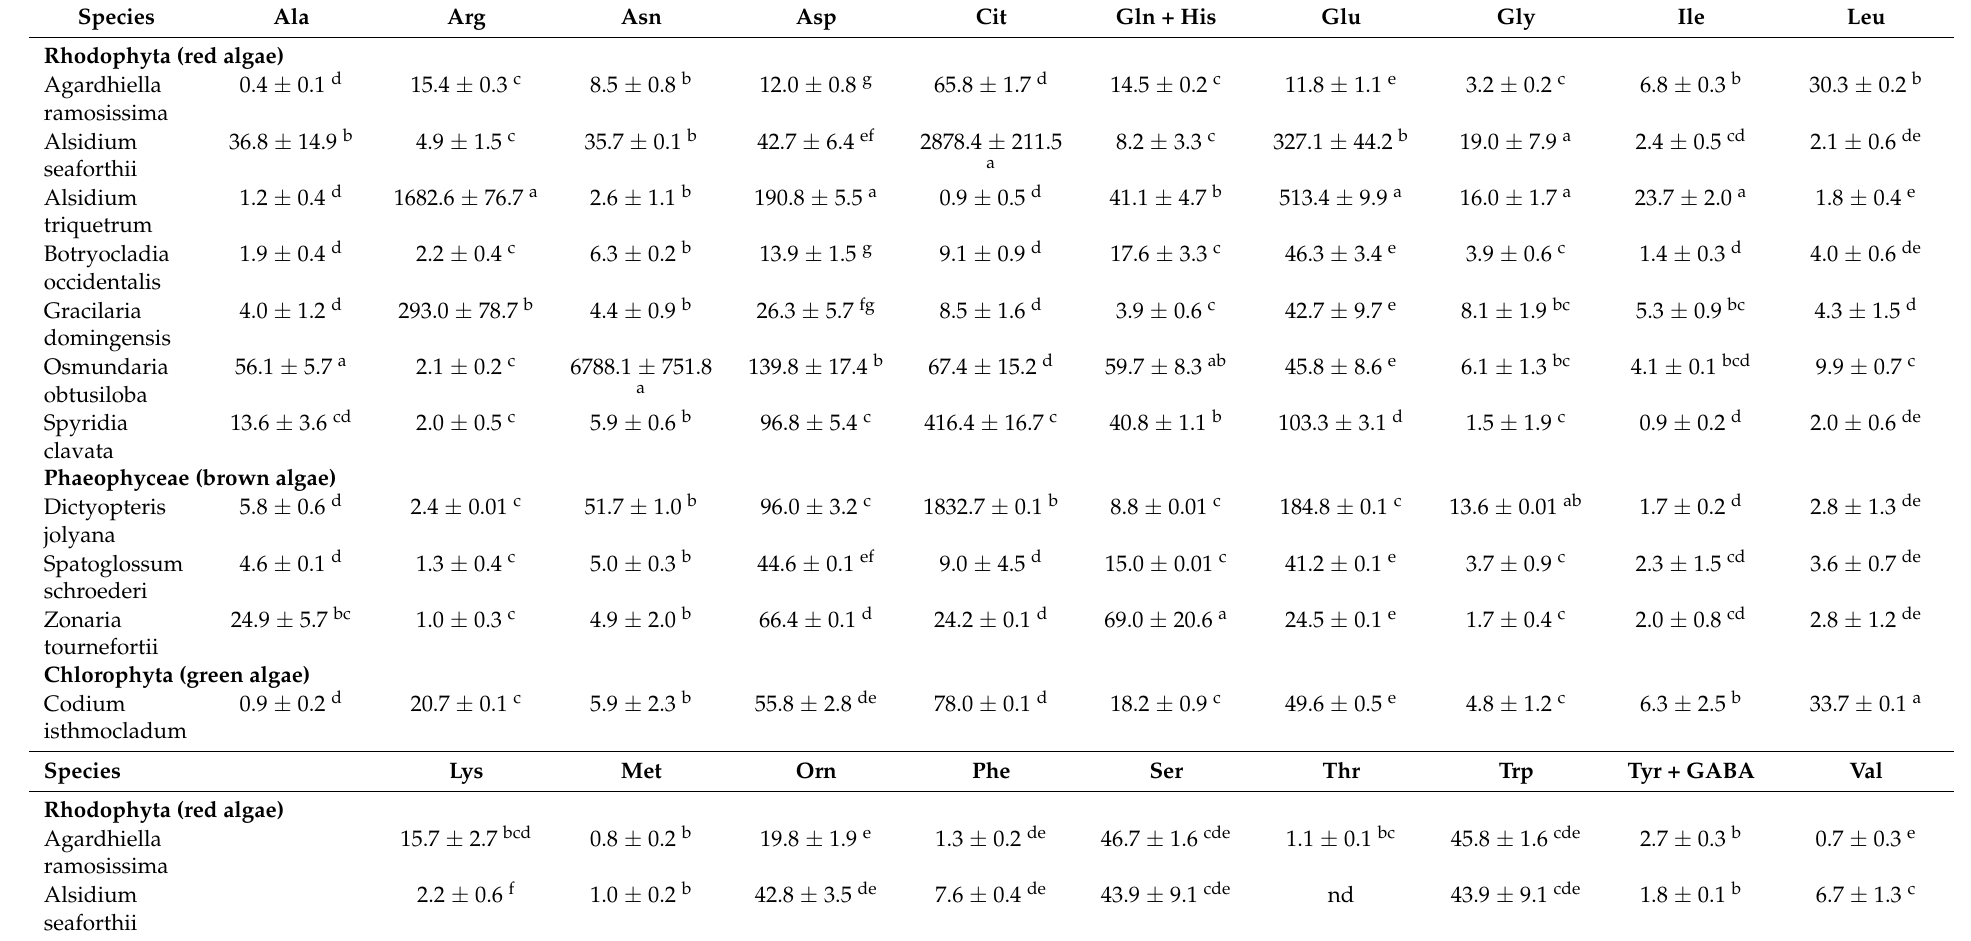
Table 3. Free amino acid composition of beach-cast macroalgae ( µ g/g on dry mass basis). Values represent the average of three replicates (mean ± SD), and letters indicate the statistical significance ( p <